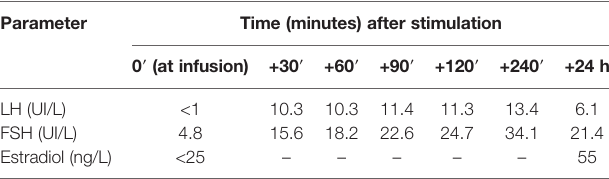
TABLE 4 | GnRH analogous